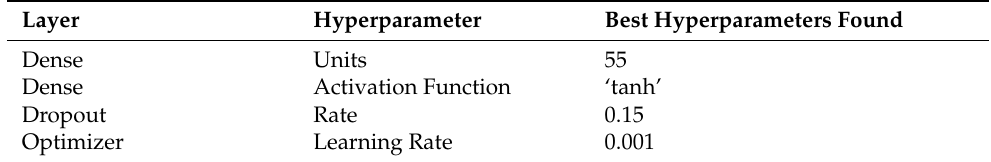
Table 6. Best hyperparameters found.